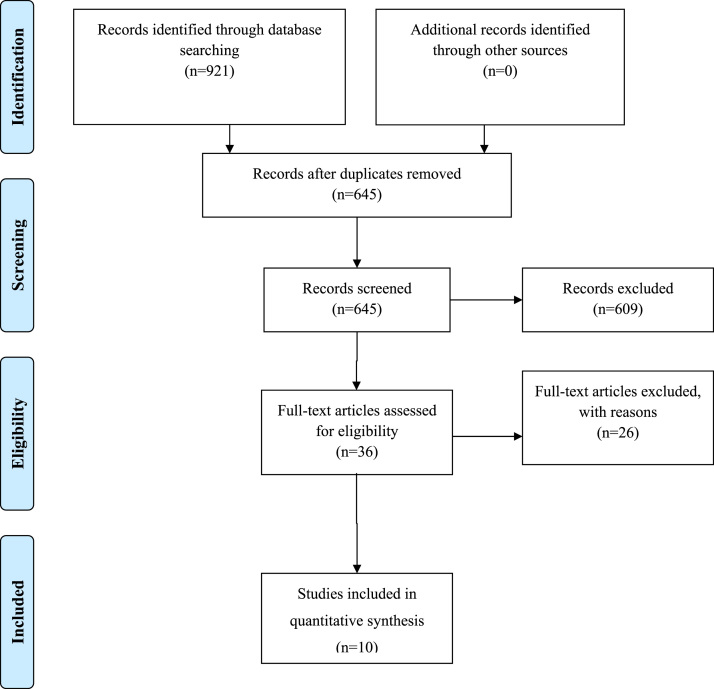
Preferred Reporting Items for Systematic Reviews and Meta-analysis (PRISMA) flow-chart.